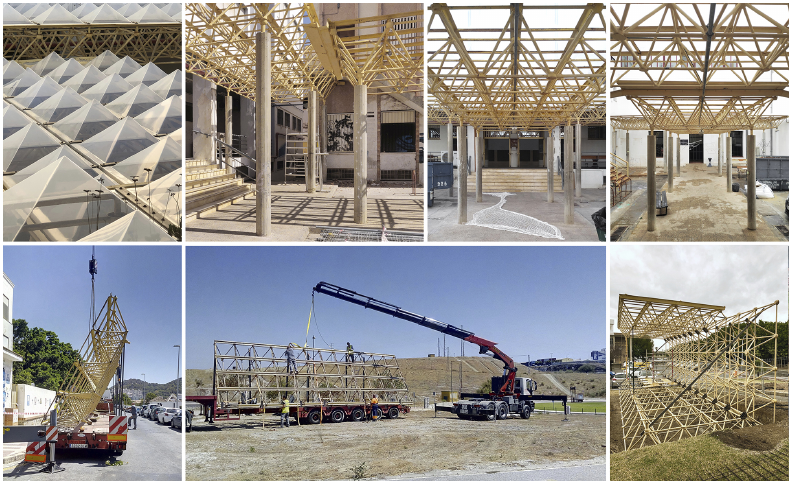
Figure 2. Images of the construction process of the Smart Tree. The top row shows the previous state of the structures located in the courtyard of the Faculty of Fine Arts. The bottom row shows the process of moving and assembling the recycled structures next to the Faculty of